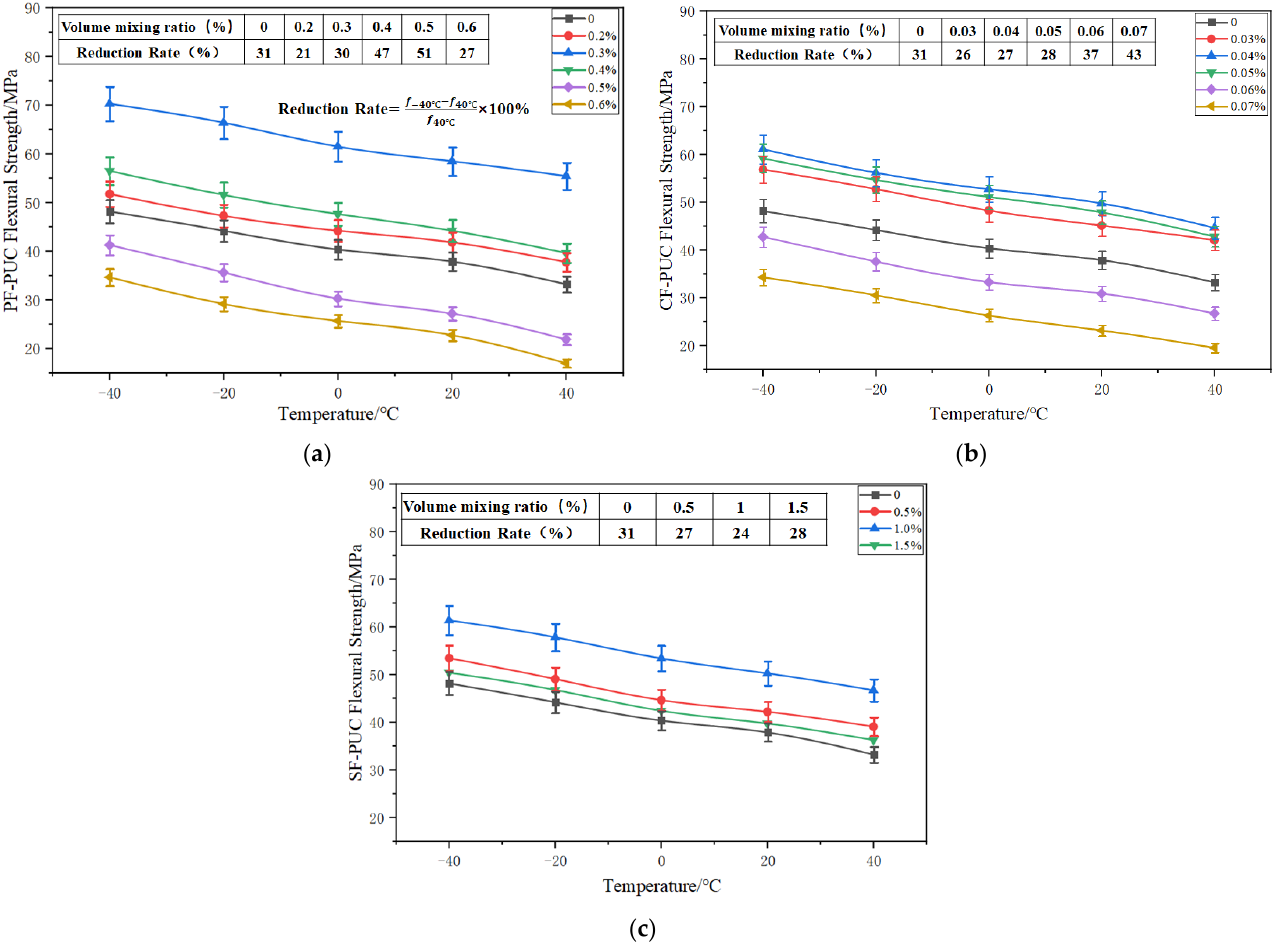
Figure 6. Flexural strength–temperature curves of different fiber volume ratios. ( a ) PF-PUC; ( b ) CF-PUC; ( c ) SF-PUC.